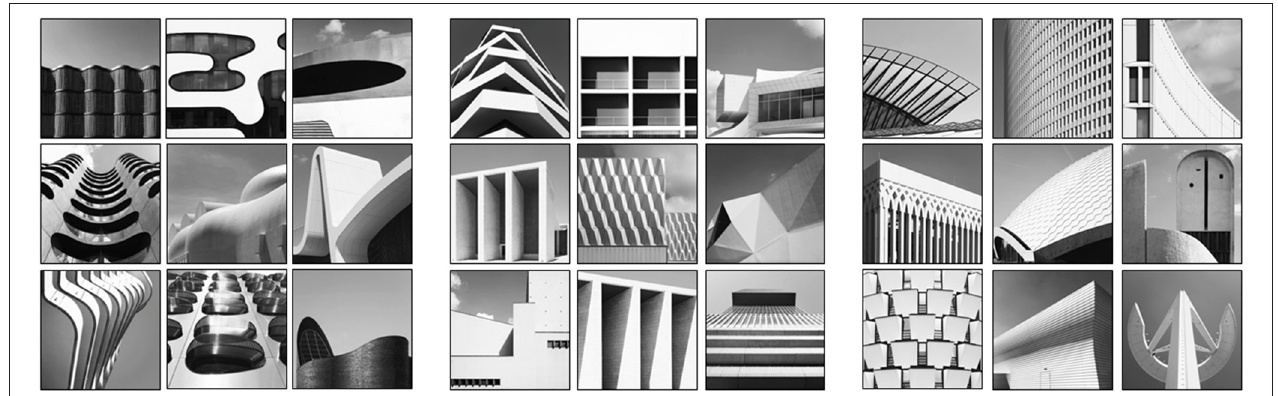
FIGURE 6 | From left to right: Nine examples of curved, angular, and mixed compositions in photographs of Sebastian Weiss.